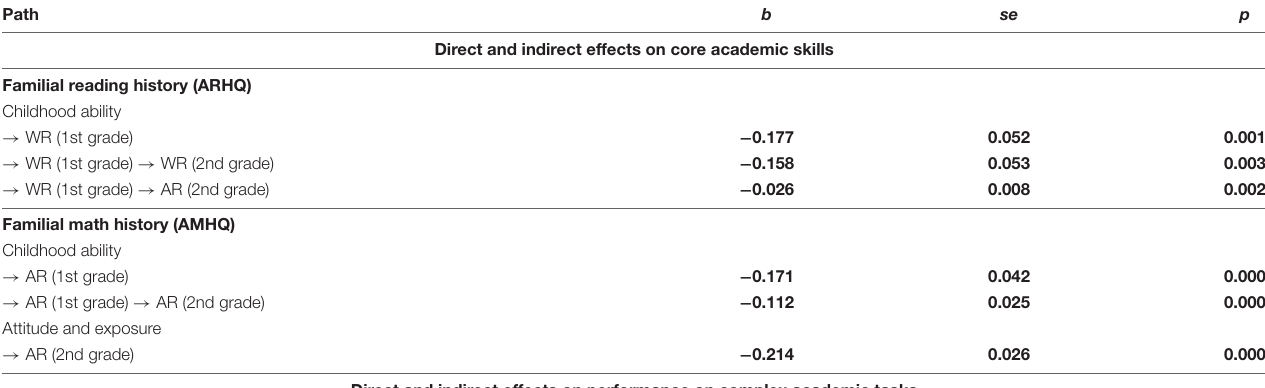
TABLE 7 | Direct and indirect effects of individual factors derived from the ARHQ (centrally, the childhood ability, attitude and exposure, and media use ones) and AMHQ (the childhood ability and attitude and exposure ones) on children’s core academic skills (WR and AR), and performance on complex tasks (RC and PS). Path b se